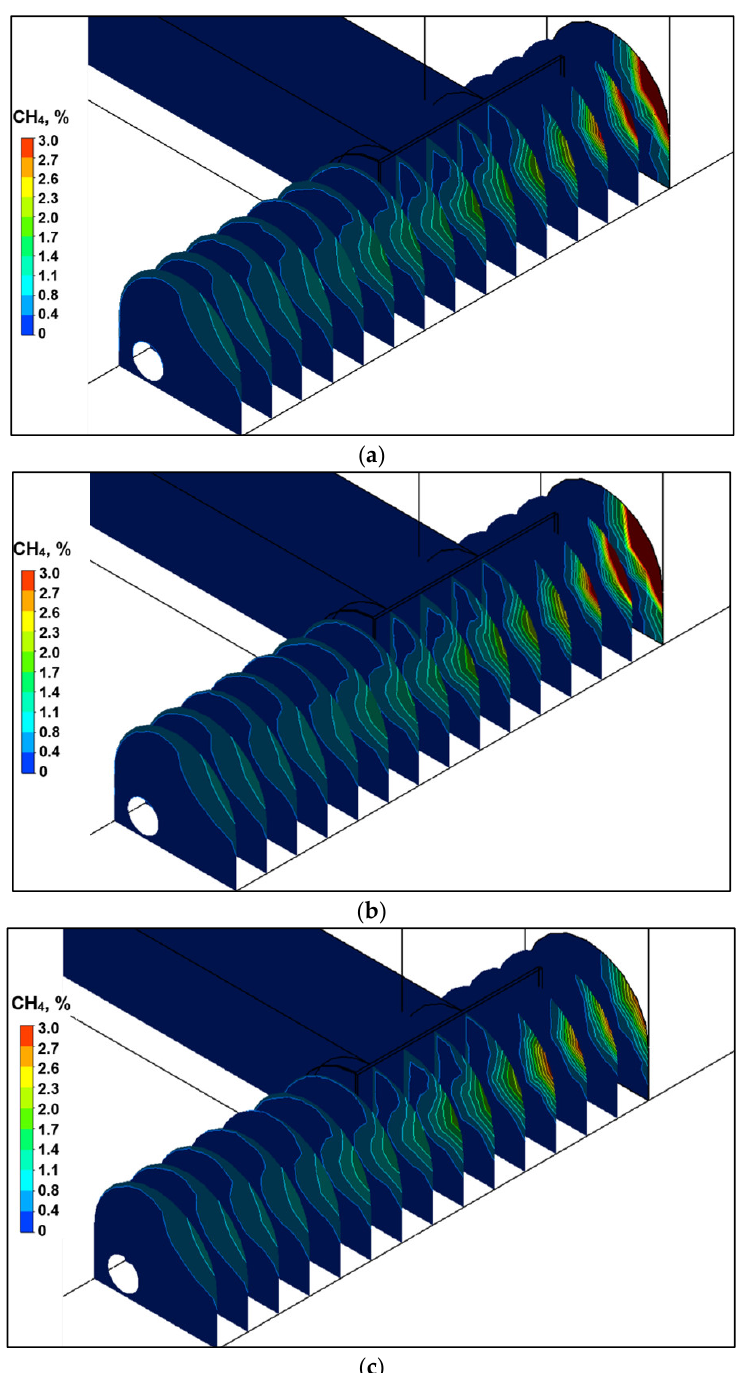
Figure 19. The distribution of methane concentration in the tailgate with built-in AVE and an additional stream of air supplied along the auxiliary air duct with the following capacities: 165.0 m 3 /min ( a ), 188.0 m 3 /min ( b ) and 212.0 m 3 /min ( c